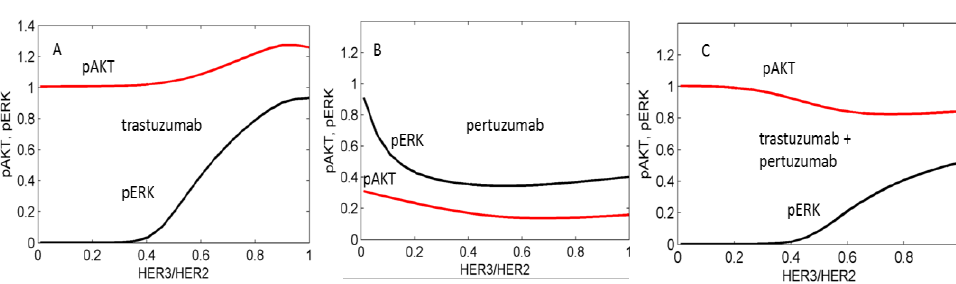
Figure 5. Computational results of the effects of trastuzumab ( A ), pertuzumab ( B ), and their combination ( C ) on pAKT (red lines) and pERK (black lines) signals depending on the ratio HER3/HER2. pAKT and pERK signals are normalized to their values in the absence of drugs. Minimum concentration of HER3 is 5